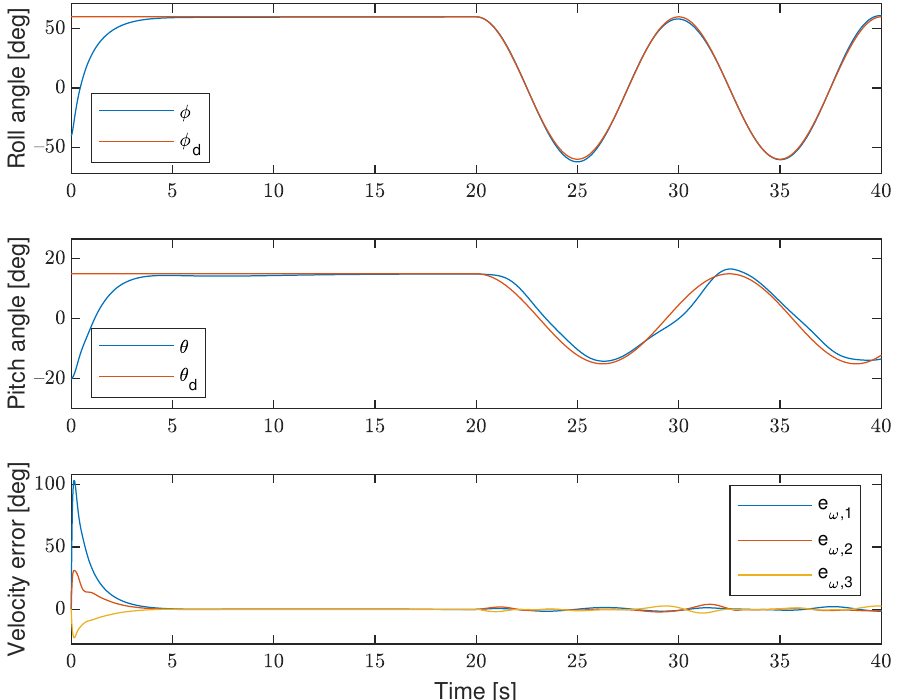
Figure 5. Roll and pitch angles vs. references, and velocity tracking error e ω .